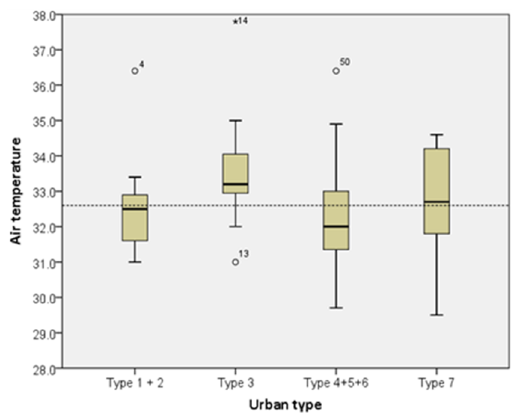
Figure 6. Distribution of air temperature by urban pattern types.